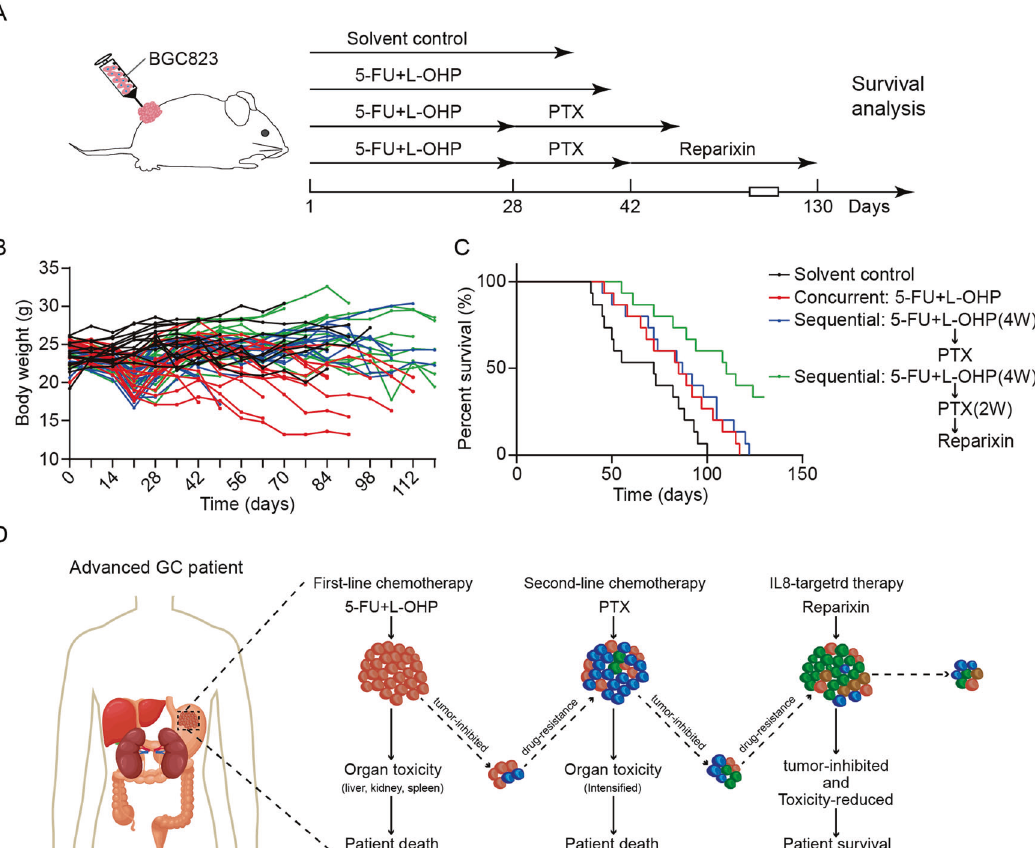
Fig. 6 Sequential treatment with fi rst-line, second-line chemotherapy and reparixin prolong the survival time of the GC-bearing mice. A Schematic representation of the survival model that subjected to sequential treatment with fi rst-line, second-line chemotherapy and reparixin ( n = 15 per group). B The body weights at the indicated time points after indicated treatments. C Kaplan – Meier survival curve after indicated treatments. D The graphic illustration of sequential treatment with fi rst-line, second-line chemotherapy and reparixin in suppressing GC